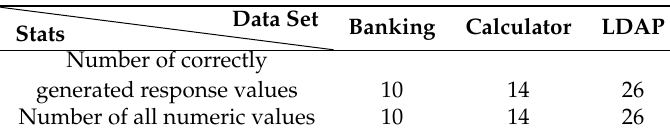
Table 3. Number of numeric fields in all message types in each protocol and the number of correctly generated responses by CSV.